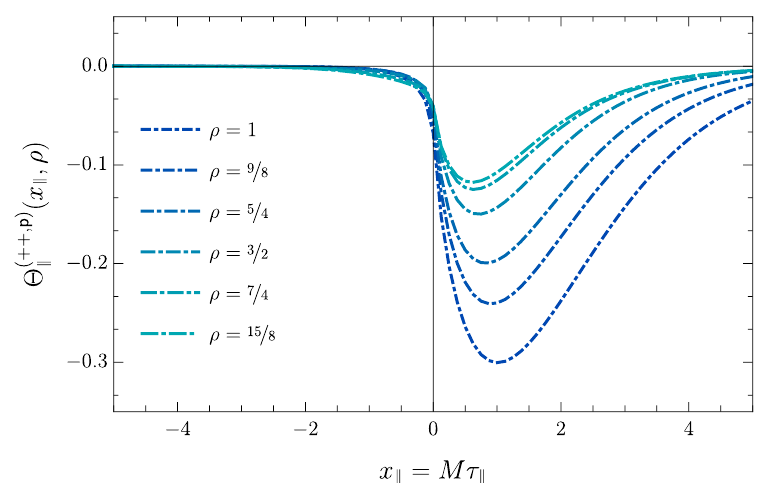
(++ , p ) ( x , ρ ) for different values of the aspect ratio Figure 17: Scaling function Θ 1 ≤ ρ ≤ 2. The scaling function converges rather fast agains its limiting case (5.21), and its minimum is minimal for ρ ≈